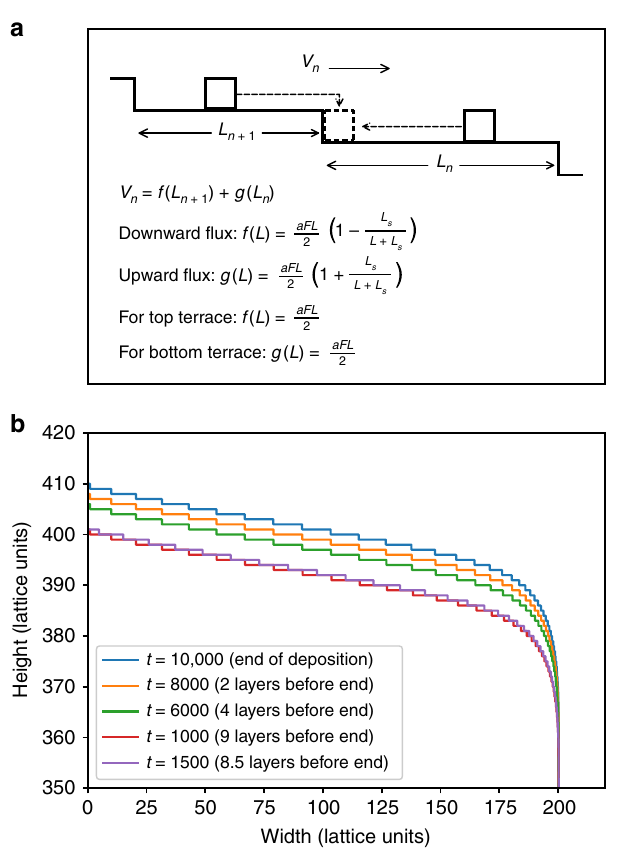
Fig. 5 Schematic diagram of the step- fl ow growth model. a In the Zeno model, the velocity of step n is determined by the widths of the upper ( L n + 1 ) and lower ( L n ) terraces. Ad-molecules diffusing on the upper terrace attach to the step-edge by descending from above, while those below attach directly. b The propagation of steps on the surface is shown at various times during the growth, starting with the top terrace at a height of 400 lattice units, and ending when the top terrace nucleates at a height of 410 lattice units. L s is equal to 4. The Zeno model is explained in the main